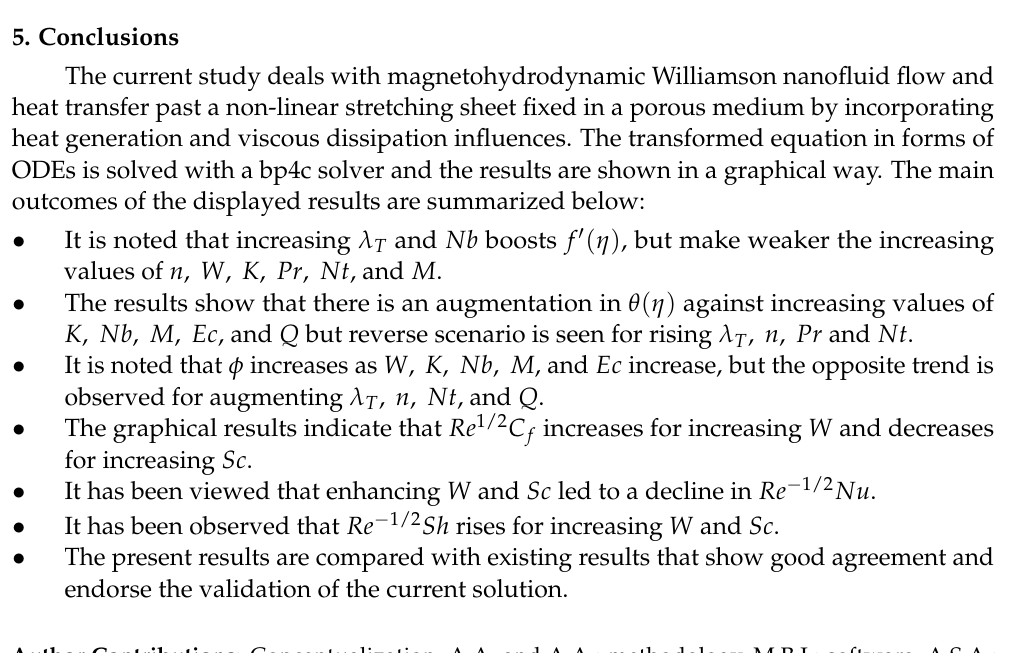
Table 1. Comparison of Nusselt number W = M = Nt = Nb = Ec = Q = Sc = 0 and n = 1. P r Gorla and Sidawi